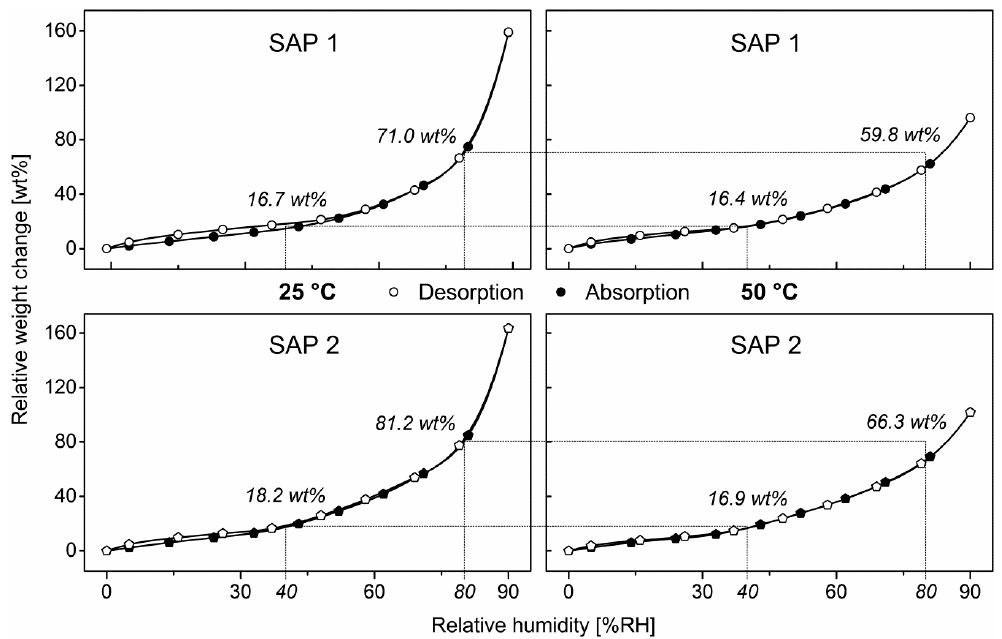
Figure 5. Sorption isotherms of SAP 1 and SAP 2 at 25 °C and 50 °C from dynamic water vapor sorption measurements between 0 and 90% RH with a 180 mL/min humidified nitrogen flow.